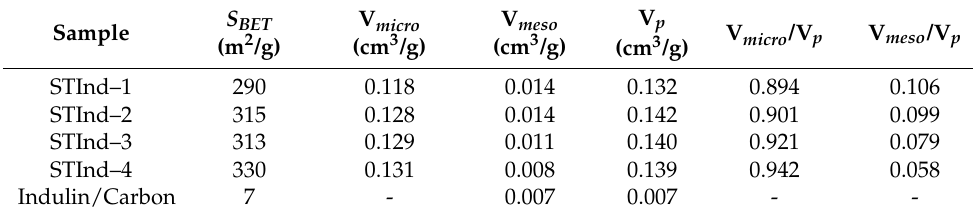
Table 2. Textural characteristics of